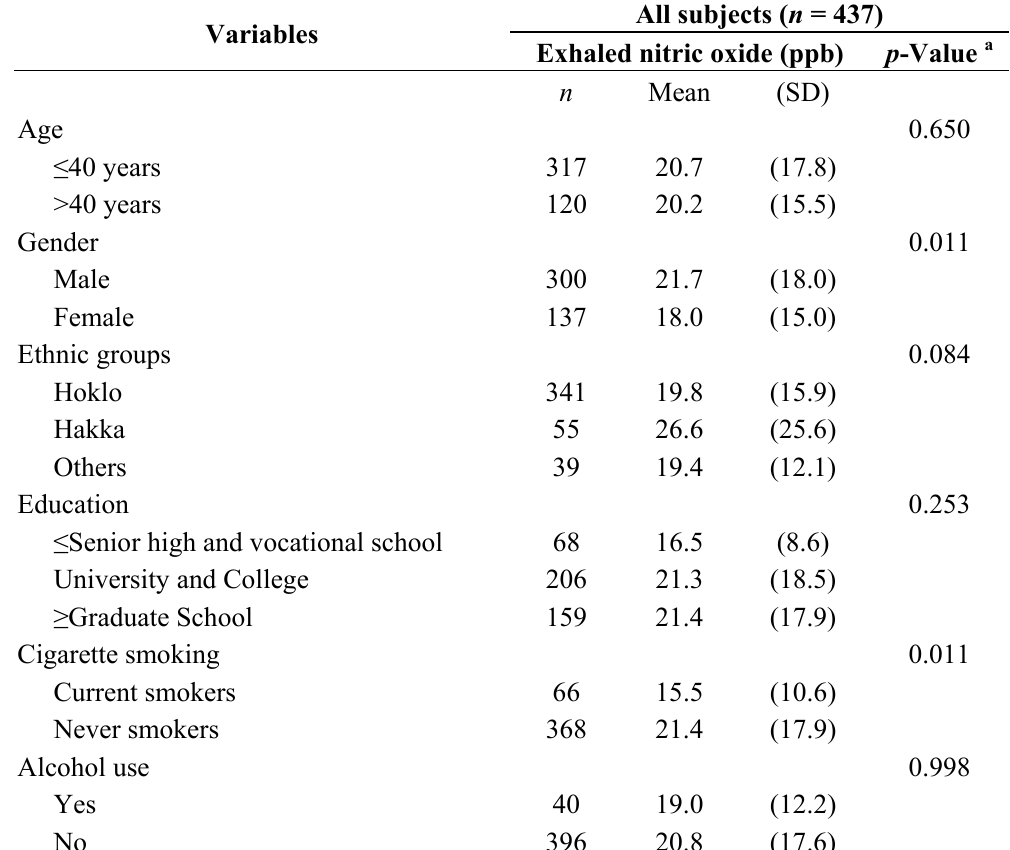
Table 1. Demographic characteristics and fractional exhaled nitric oxide (FENO) values of study participants ( n =